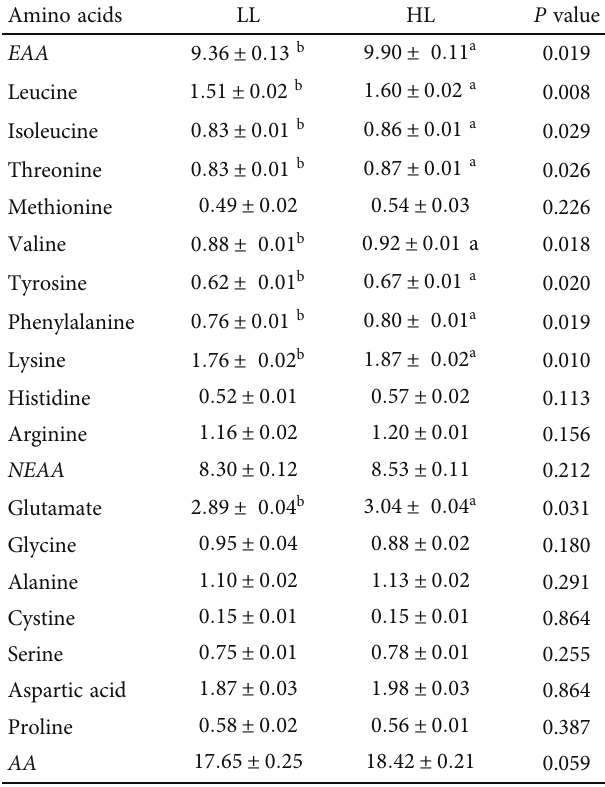
Table 4: Muscle amino acid composition (g/kg of fresh weight) of blunt snout bream fed the trial diets ( Mean ± SEM , n = 4 ).